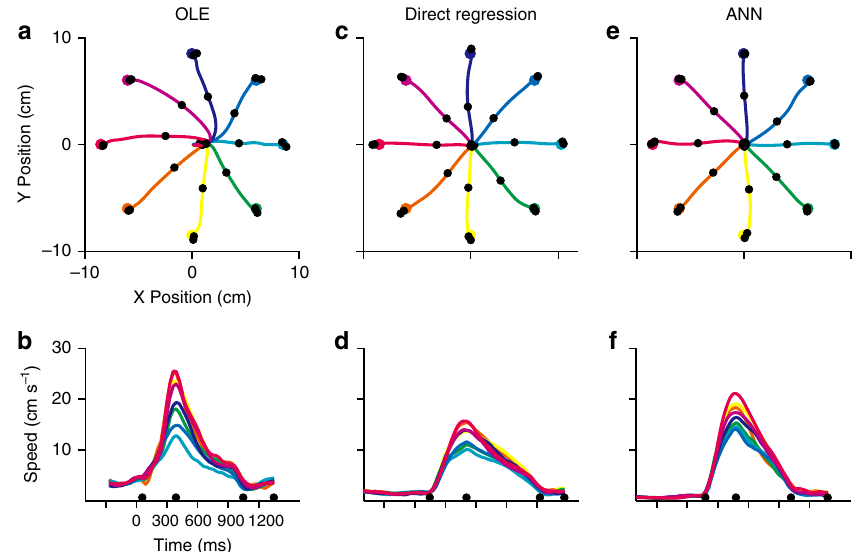
Fig. 8 Comparison of BCI performance using variance-only OLE, Direct Regression and hybrid ANN decoders. a , c , e Average trajectories in the last sessions (45, 38 and 45 trials per target, respectively) for OLE (day 4), Direct Regression (day 6) and hANN (day 6). b , d , f . Speed pro fi les for OLE, Direct Regression and hANN. Note that speed pro fi les were temporally aligned and resampled for presentation, but their magnitudes were not scaled. Time zero represents target onset. Center-hold phase was shortened for OLE to increase success rate and maintain motivation